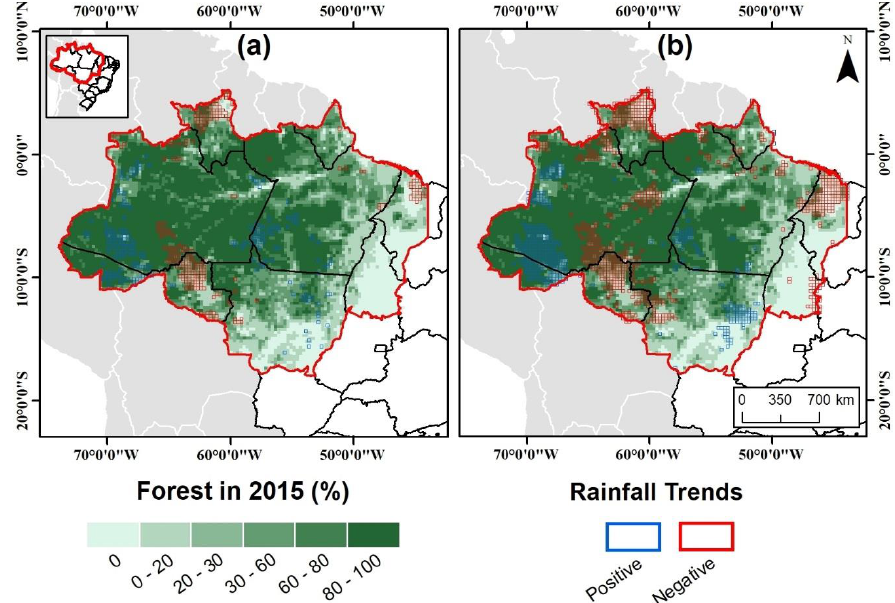
Figure A1. Spatial distribution of the old-growth forest in the study area for the year 2015 from the forest mask of the PRODES/INPE Project [101]. Forest areas were calculated as percentage in 27 by 27km cells (spatial resolution similar to Tropical Rainfall Measuring Mission (TRMM) satellite data). ( a ) Annual rainfall trends and ( b ) seasonal rainfall trends.